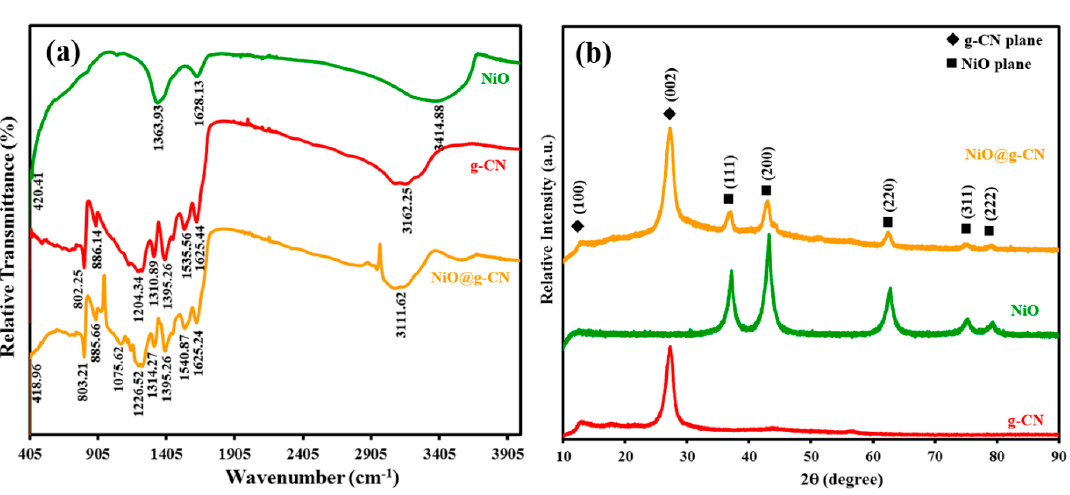
Figure 2. ( a ) ATR-FTIR spectra of g-CN, NiO, and the NiO@g-CN nanocomposite. ( b ) XRD patterns of pure g-CN, pure NiO, and the NiO@g-CN nanocomposite.